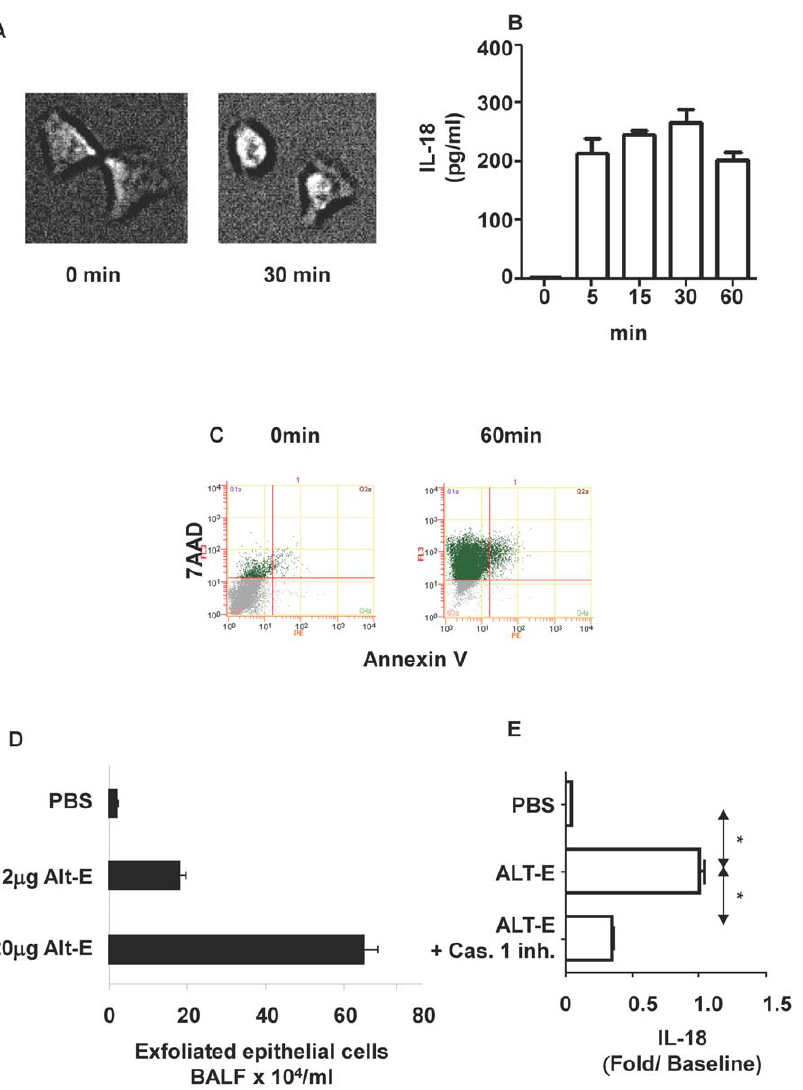
Figure 2. Induction of epithelial cell necrosis by ALT-E. ( A ) A549 cells were cultured with ALT-E for 30 min. Changes in cell morphology were monitored by live cell imaging. ( B ) Time course of ALT-E-induced IL-18 release from airway epithelial cells. ( C ) Exposure of cultured A549 epithelial cells to ALT-E induces cell necrosis. ( D ) ALT-E challenge of mice induces sloughing of trypan blue positive necrotic airway epithelial cells (n=4 per group). ( E ) Caspase 1 inhibitor (Cas.1 inh.) reduces IL-18 release from A549 airway epithelial cells cultured with